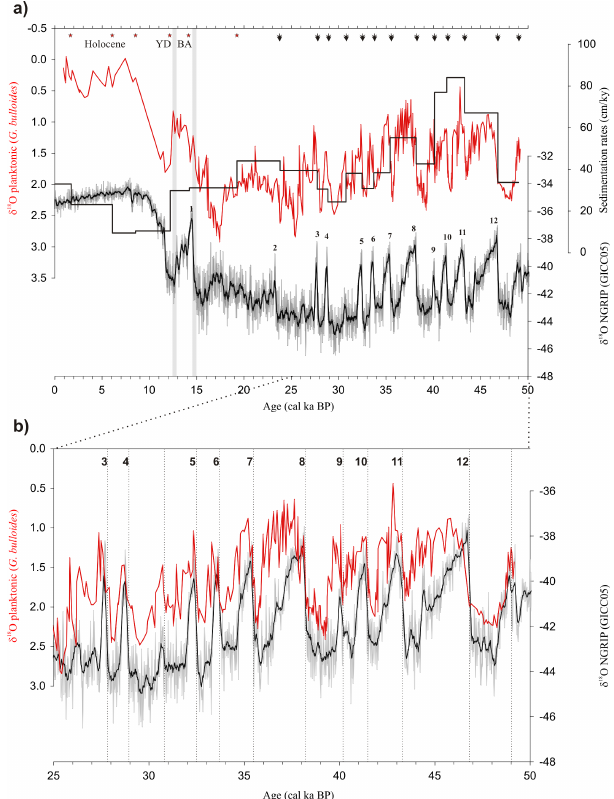
Figure 3. Comparison, against age (new age model from this study), between the planktonic δ 18 O monospecific record of core MD99- 2339 (red curve; Voelker et al., 2006) and the NGRIP δ 18 O accord- ing to the GICC05 timescale (Svensson et al., 2008). (a) Red stars show the six radiocarbon dates retained for the chronology of core MD99-2339, and dark arrows show the 13 pointers used to tune the δ 18 O data of core MD99-2339 to the NGRIP chronology, by con- sidering GI onsets for core MD99-2339 (numbers 1 to 12 in the figure) according to GI onset chronology established in Wolff et al., (2010). Sedimentation rates, calculated between different pointers of core MD99-2339, are also highlighted by the dark histogram. YD: Younger Dryas; BA: Bölling–Alleröd. (b) A close-up of the 25–50kaBP interval allows for better consideration of the pointers selected (dotted vertical lines) for this new age